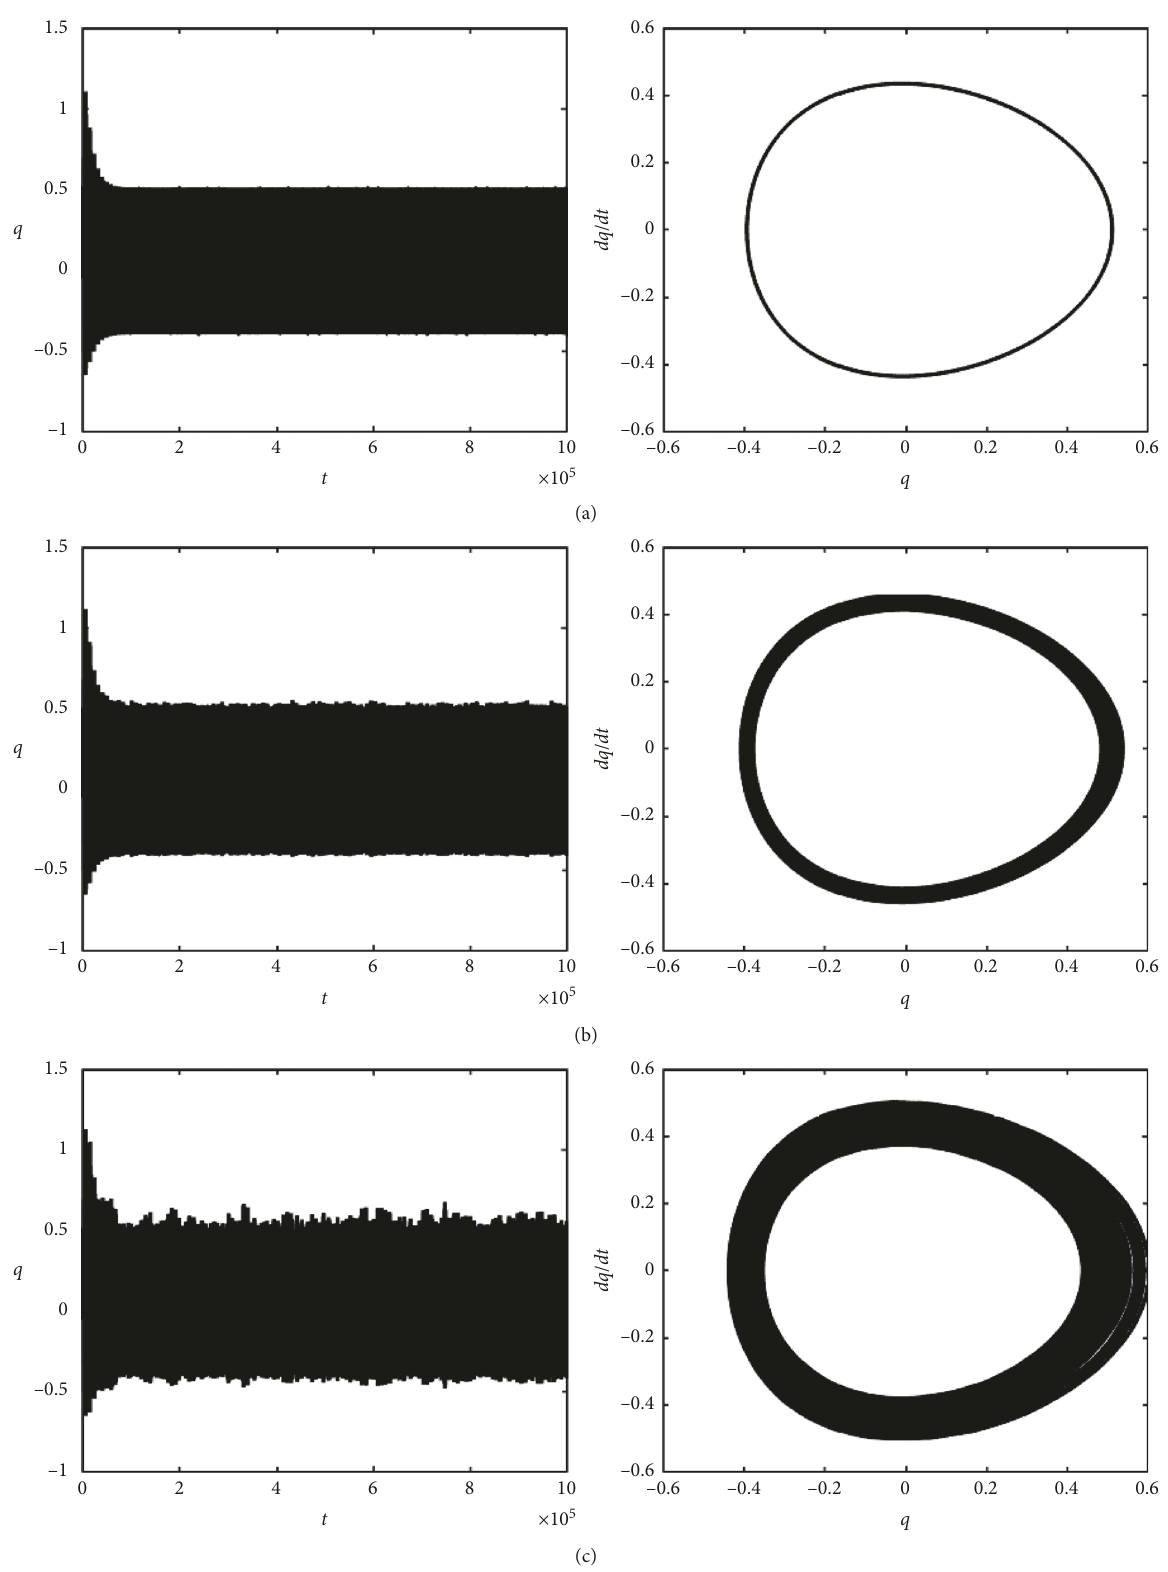
Figure 7: Time history curves and phase diagrams with variable D when v � 100m/s. (a) D � 0, (b) D � 10, and (c) D �